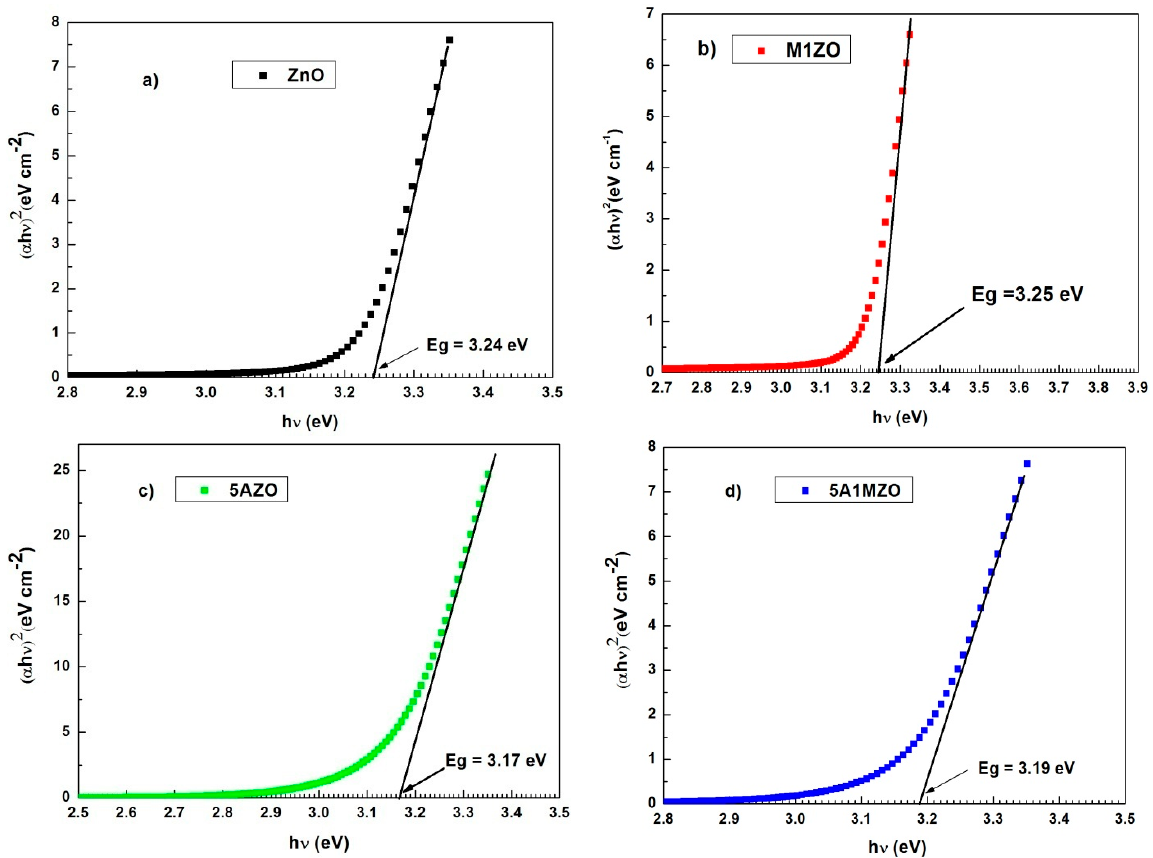
Figure 9. Plots of ( α h υ ) 2 versus photon energy ( h υ ) for ( a ) ZnO, ( b ) 1MZO, ( c ) 5AZO and ( d ) 5A1MZO samples.